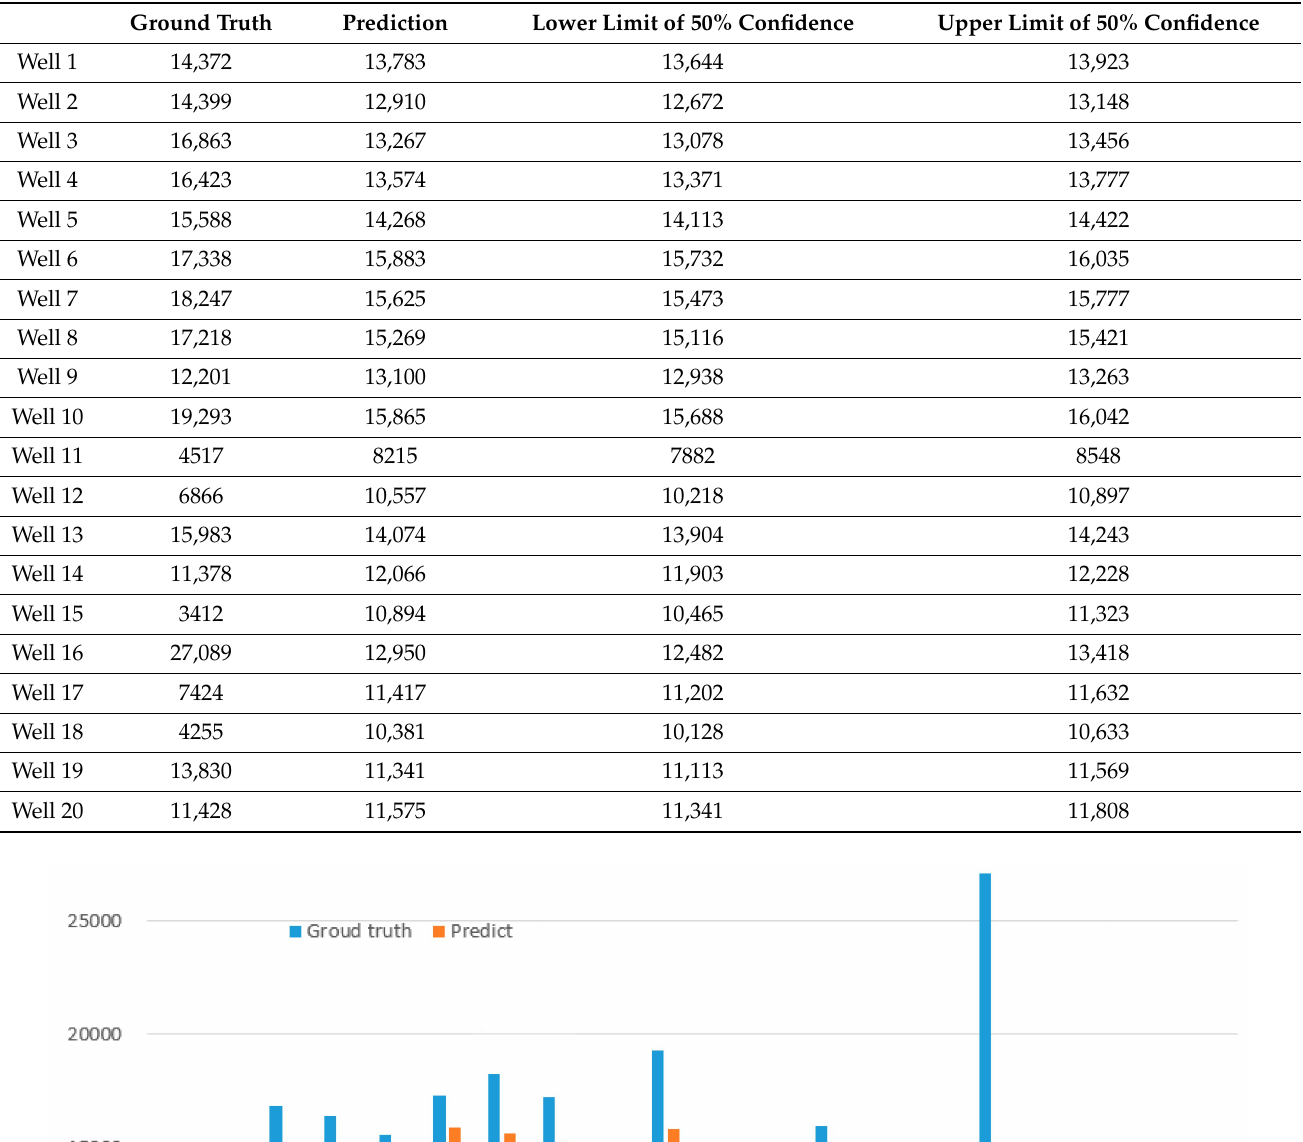
Table 1. The Results of Horizontal Shale Gas Well Capacity Prediction.